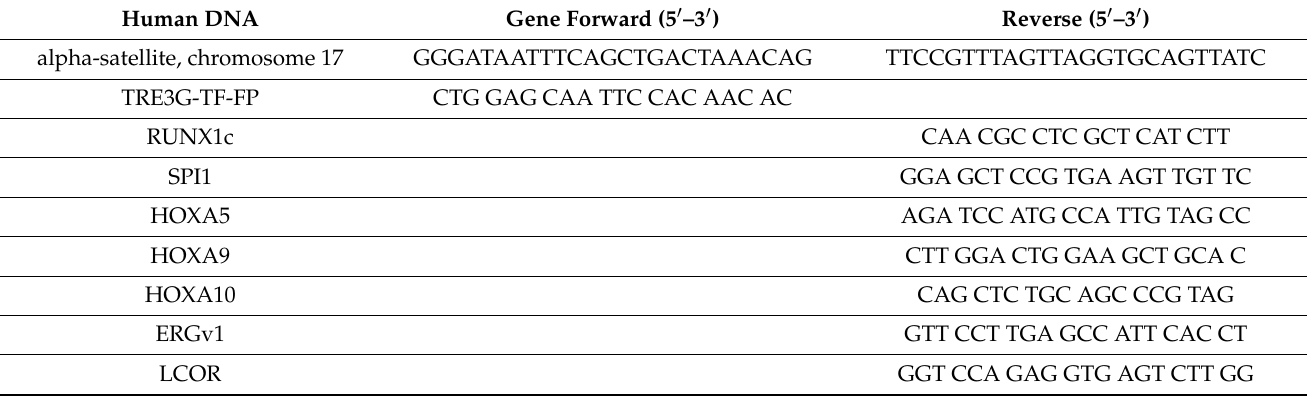
Table 4. Conventional PCR primer